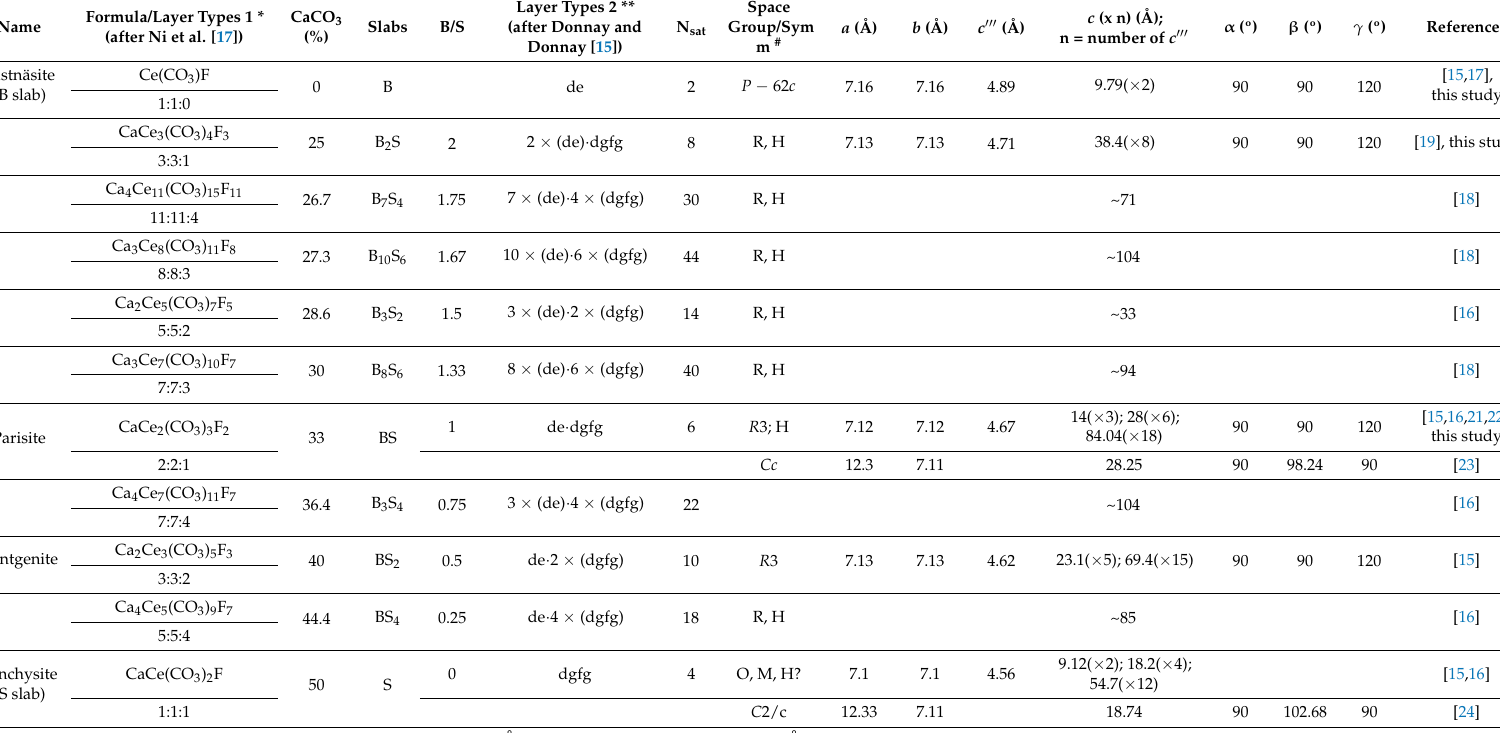
Table 1. Chemistry, crystal structures and stacking sequences for all phases known in the bastnäsite-synchysite